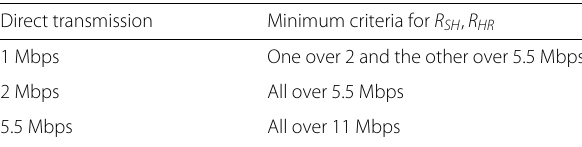
Table 2 Minimum participation criteria for cooperative